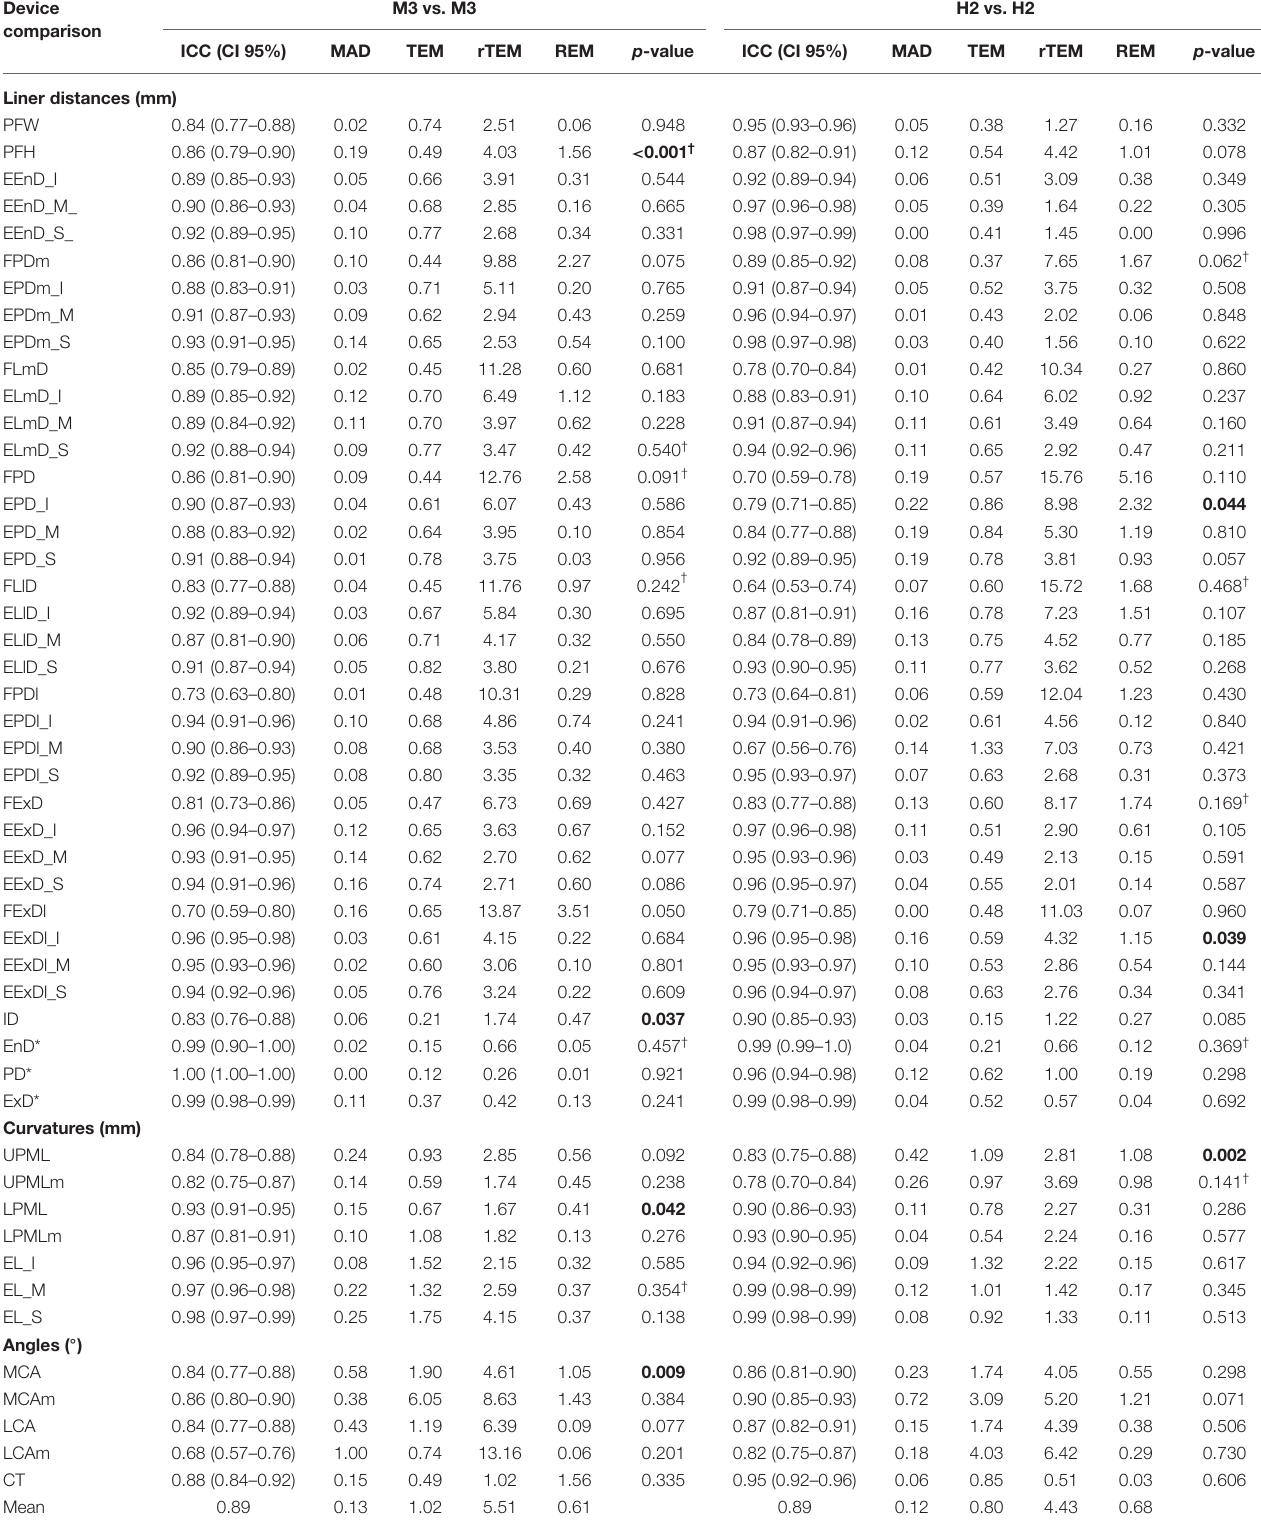
TABLE 4 | Intra-device reliability results of VECTRA M3 and H2 for periocular measurements. Device